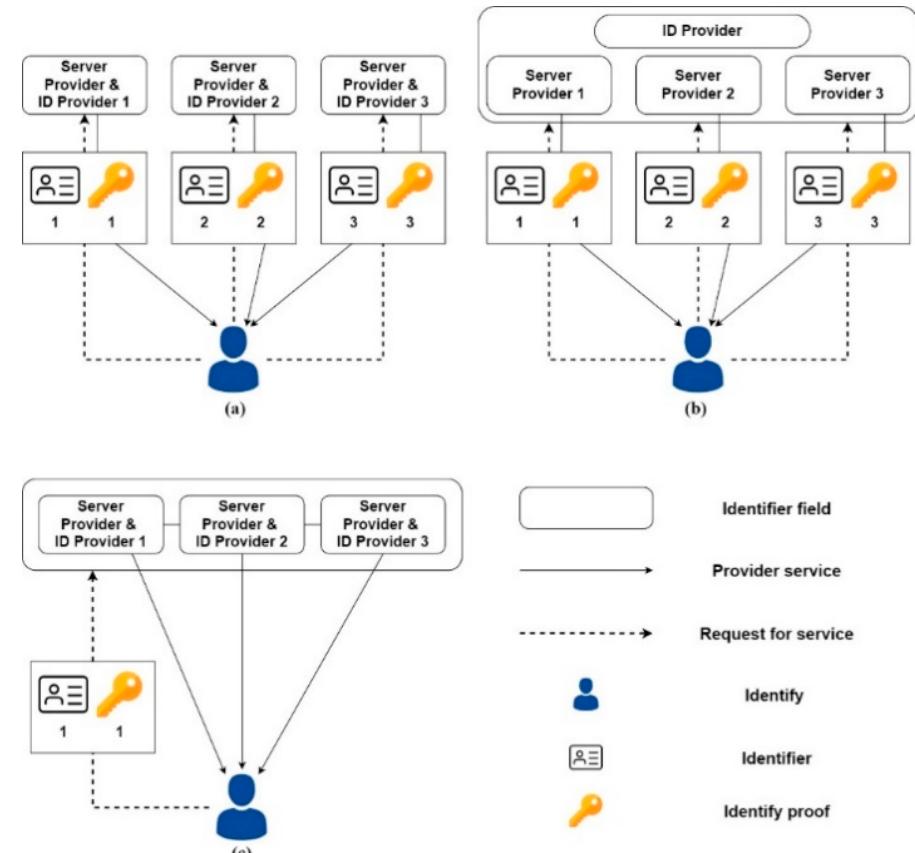
Figure 2. ( a ) Independent identity management architecture; ( b ) Centralized identity management architecture; ( c ) Federated identity management